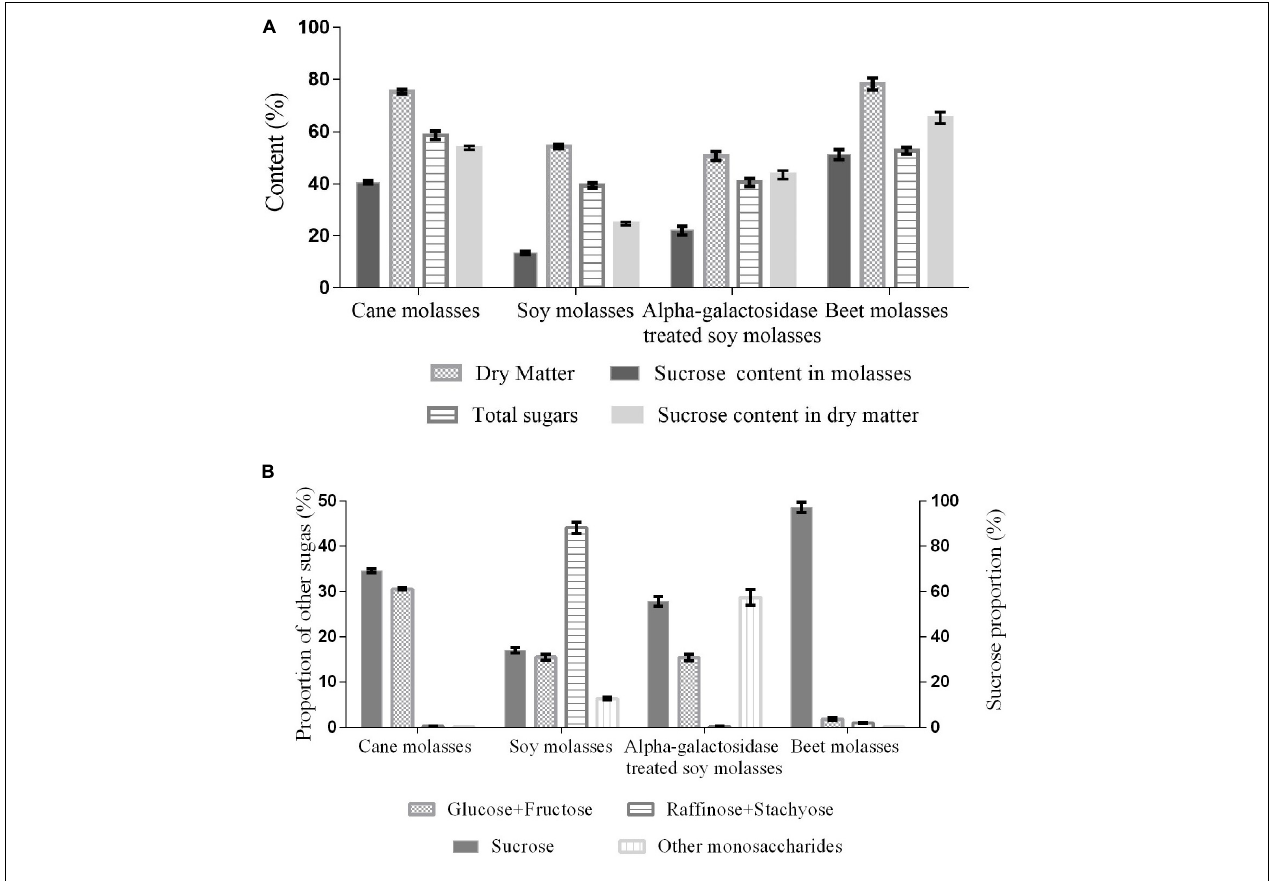
FIGURE 1 | Sugar content (A) and proportion (B) in different